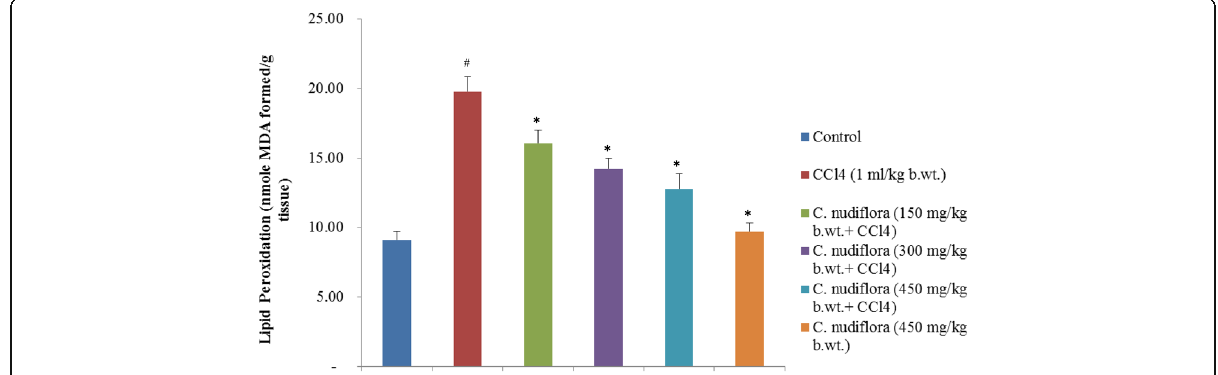
Fig. 4 Effect of C. nudiflora on CCl 4 -induced hepatic lipid peroxidation. Each value represents the mean ± S.E. of six animals. Hashtag indicates significance at p < 0.05 compared to the control group. Asterisk indicates significance at p < 0.05 compared to the CCl 4 -treated